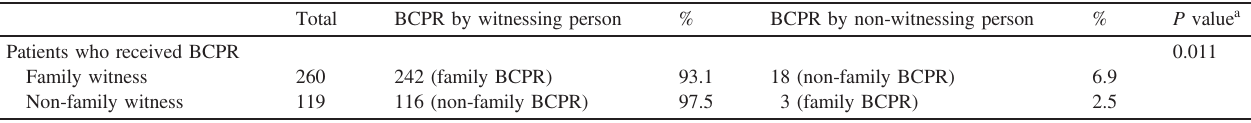
Table 3. Association between witnessing family and non-family members among the patients who received bystander cardiopulmonary resuscitation performed by the witnessing person Total BCPR by witnessing person % BCPR by non-witnessing person Patients who received BCPR